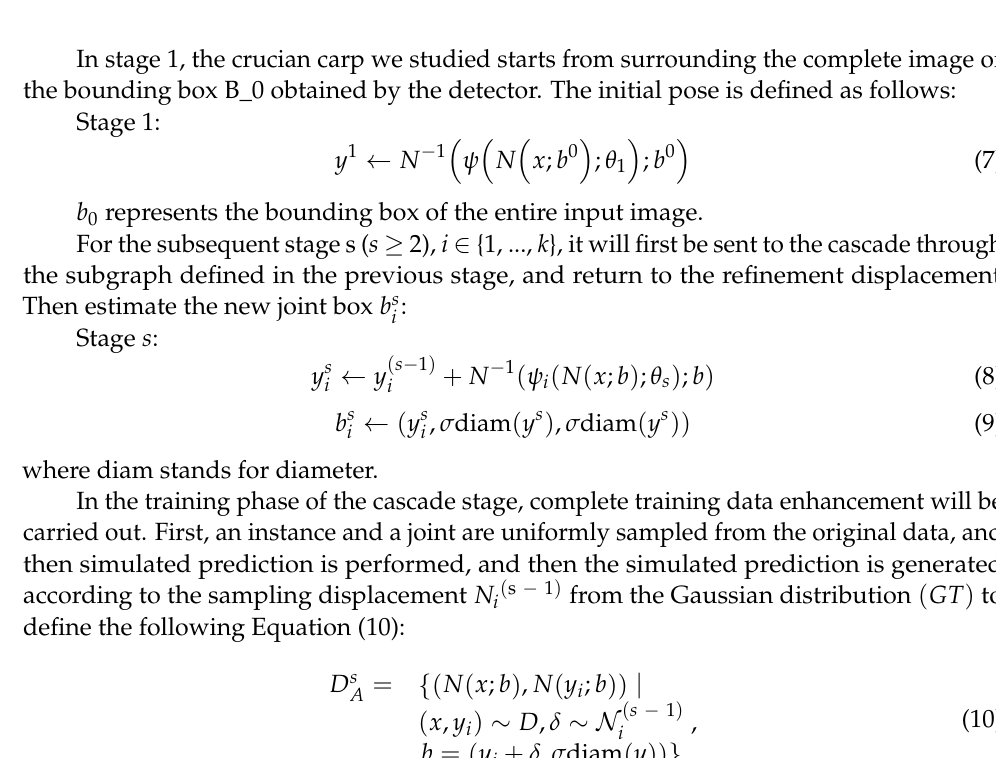
Figure 11. In the DeepPose stage s, the refinement cascade is applied to the sub-image to refine the prediction of the previous